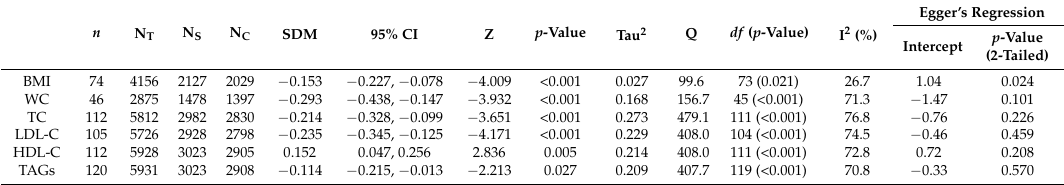
BMI: Body Mass Index; WC: Waist Circumference; TC: Total Cholesterol; LDL-C: Low density Lipoprotein Cholesterol; HDL-C: High Density Lipoprotein Cholesterol; TAGs: Triglycerides; n : total number of